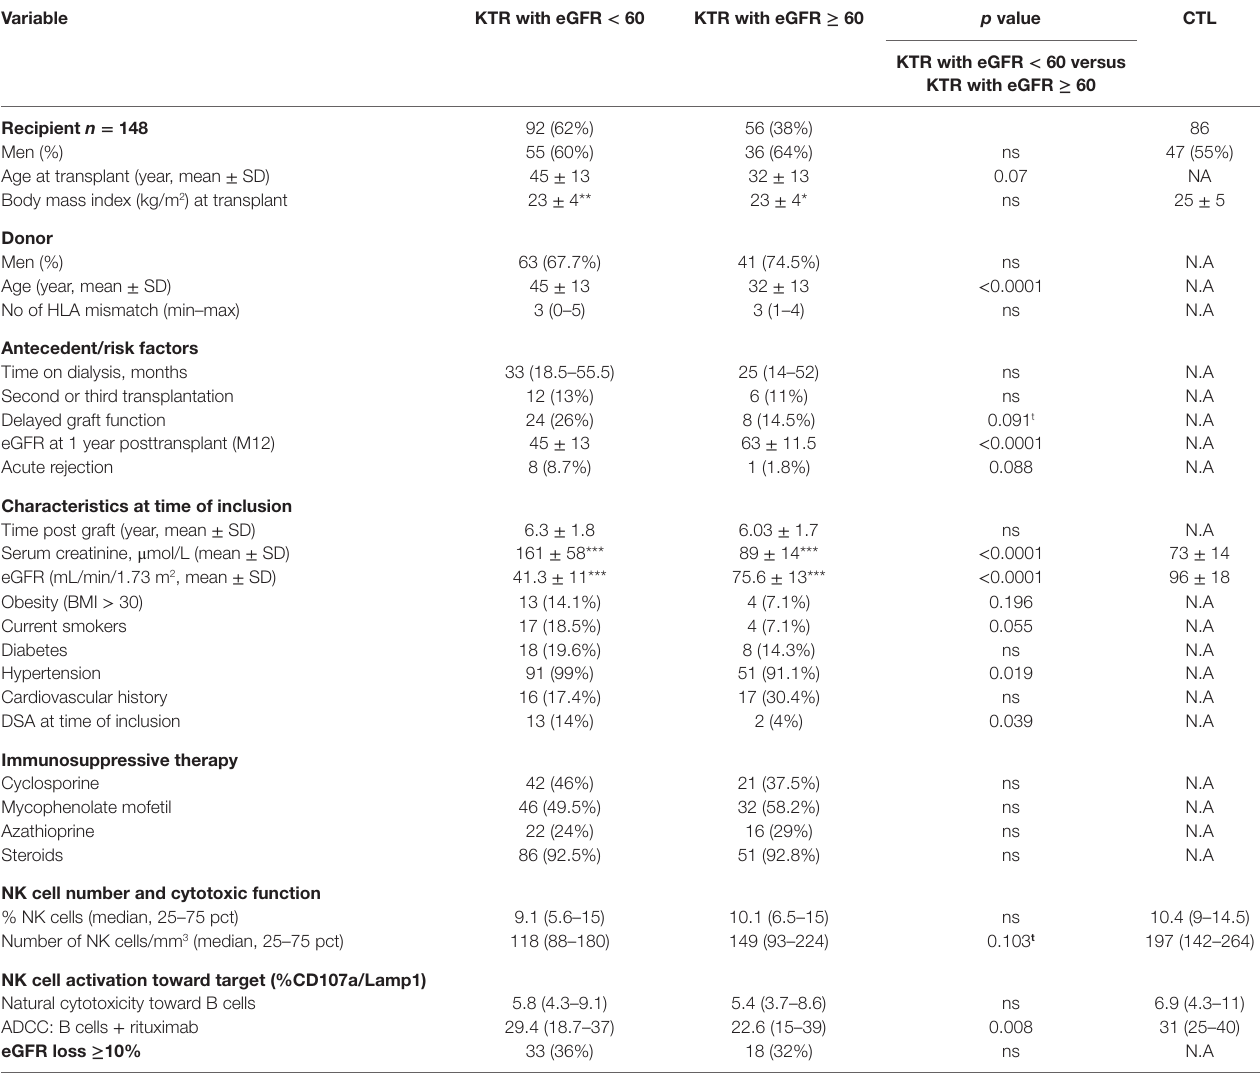
TaBle 1 | characteristics of the 148 KTrs according to transplant